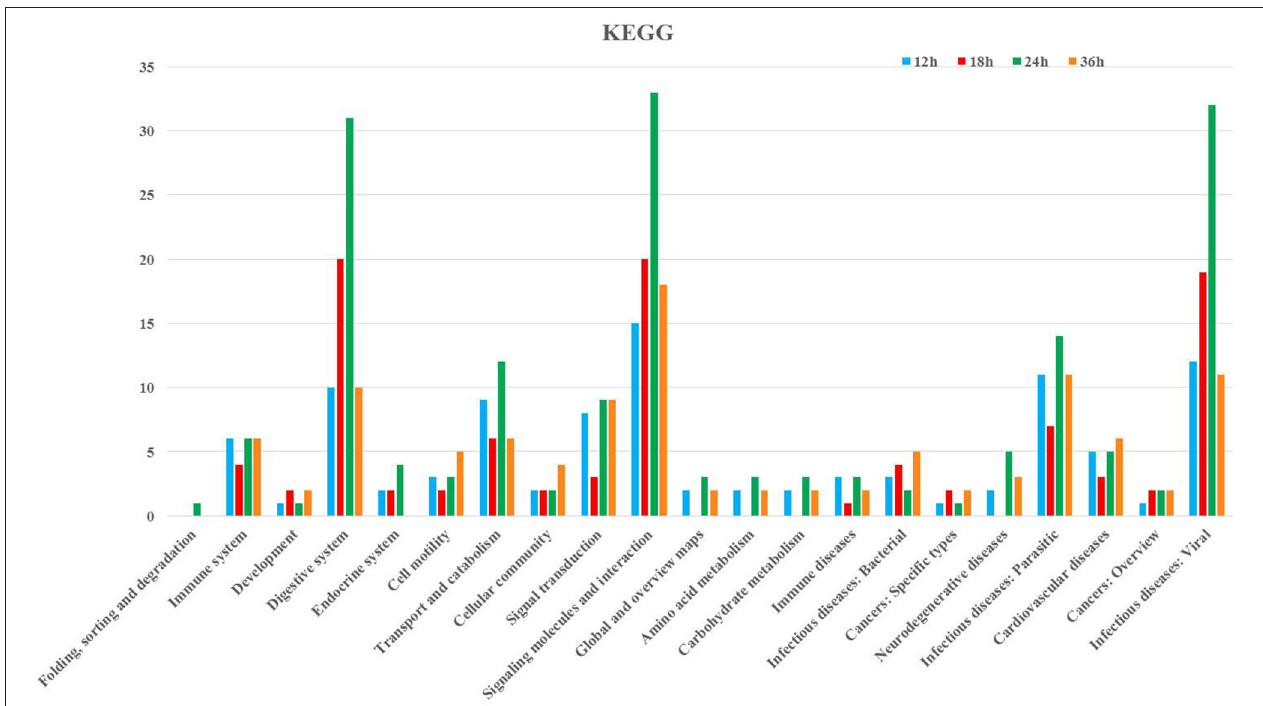
FIGURE 4 | KEGG pathway annotation classification of immunity-related genes in P. xylostella infected with I. fumosorosea at 12, 18, 24, and 36 h. The abscissa is the KEGG classification, and the ordinate left is the gene number.